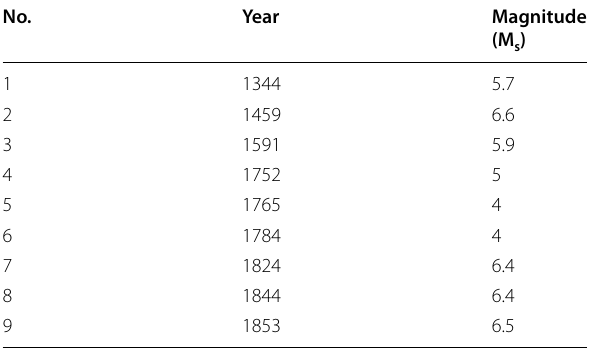
Table 1 Historical earthquakes near Yazd province (Source: Ambraseys and Melville 2005)